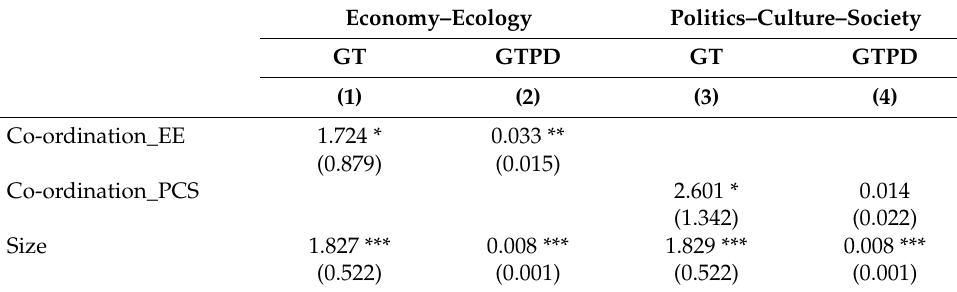
Table 4. The impact of economy–ecosystem co-ordination on